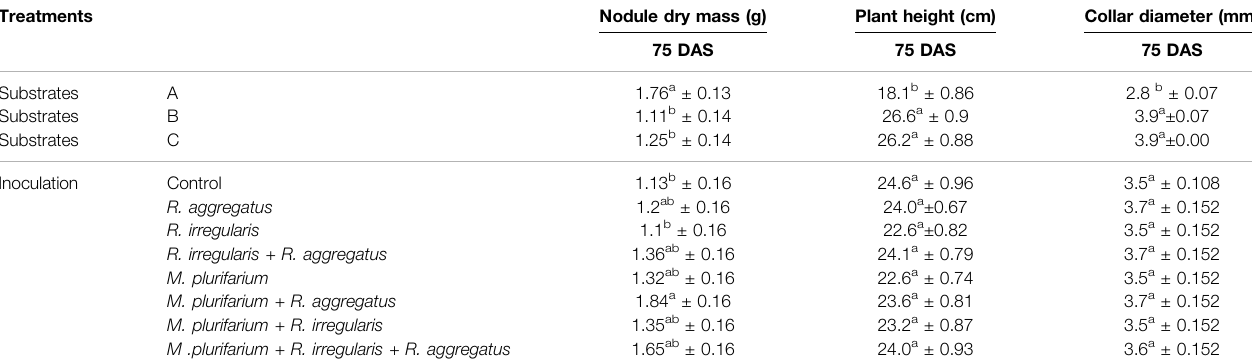
(DAS) days after sowing.